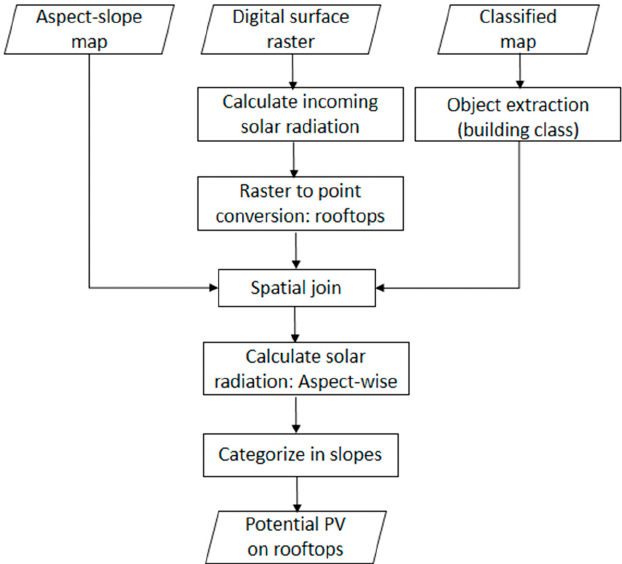
Figure 4. The implemented methodology to estimate photovoltaic (PV) potential.